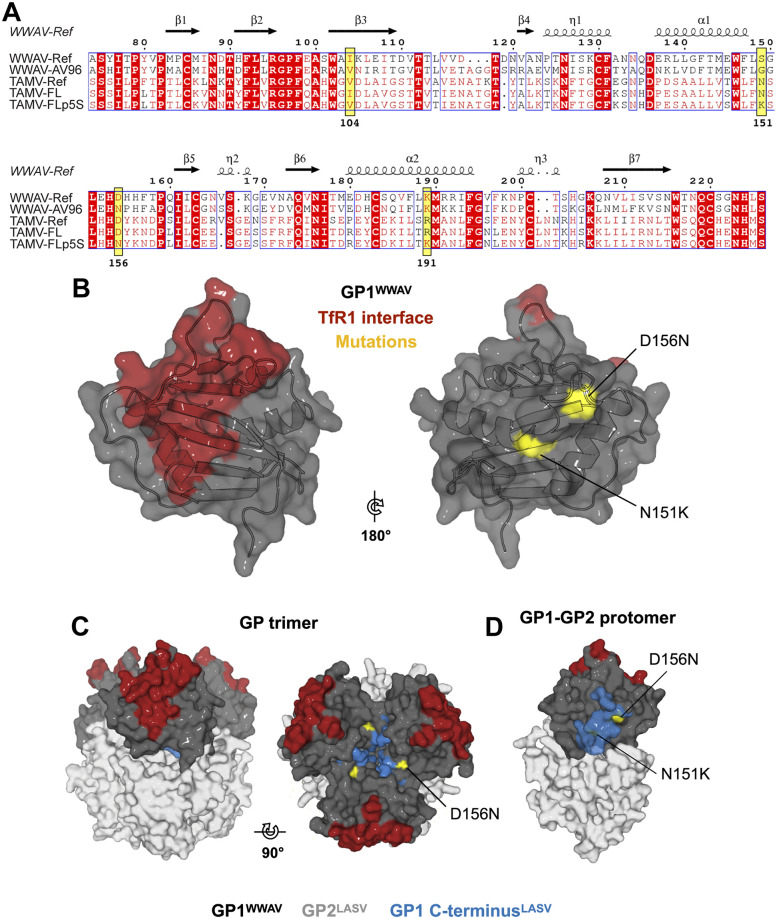
Structure-based mapping of acquired TAMV mutations.(A) Amino acid sequence alignment of NW clade D GP1s, numbered according to WWAV-Ref. Polymorphisms common to TAMV and WWAV are highlighted in yellow and numbered in accordance with TAMV-FL numbering. Secondary structural elements of WWAV GP1 are illustrated above the sequences. Alpha (α) and 310 (η) helices are shown as coils, and β-sheets (β) as arrows. Conserved residues are shown in red boxes and semi-conserved residues are shown in red font within a blue box. Alignments were displayed using ESpript (http://espript.ibcp.frhttp://espript.ibcp.fr) [109]. (B) Amino acid substitutions (yellow) acquired by TAMV_FL map to the putatively trimeric axis-facing helical region of GP1, distal to the expected TfR1 receptor binding site (red). Features are mapped onto the structure of WWAV GP1. (C) Localization of TAMV mutants in the context of a composite model of trimeric GP, excluding SSP and transmembrane domains. The GP2 subunit from the trimeric LASV GP structure is shown in light grey, with GP1 from WWAV (colored as in panel B) in place of LASV GP1. The C-terminal region of LASV GP1, which is not present in the structure of WWAV GP1, is shown overlaid in blue. (D) View of the trimeric axis-facing side of a composite GP1-GP2 protomer, colored as in panel B.